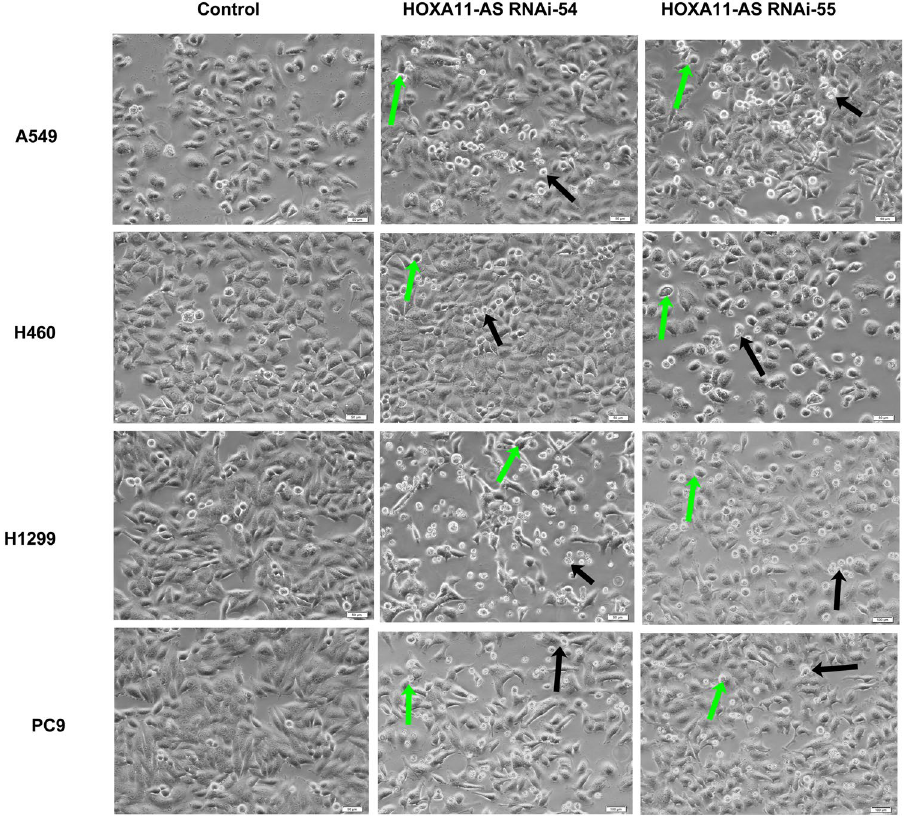
Figure 8. HOXA11-AS RNAi promoted apoptosis in A549, H460, H1299 and PC9 cell lines. Four NSCLC cell lines (A549, H460, H1299 and PC9) were transfected separately with lenti-control virus, HOXA11-AS RNAi- 54 and HOXA11-AS RNAi-55. An increased number of apoptotic cells (green arrows) and dead cells (black arrows) were observed under a light microscope (200 ×